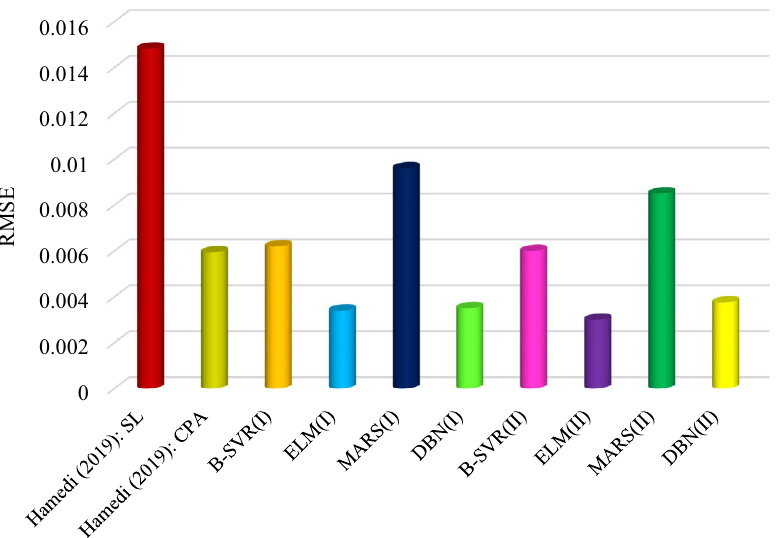
Figure 14. Comparison of the results of the current study models and equations of state used in previous studies.